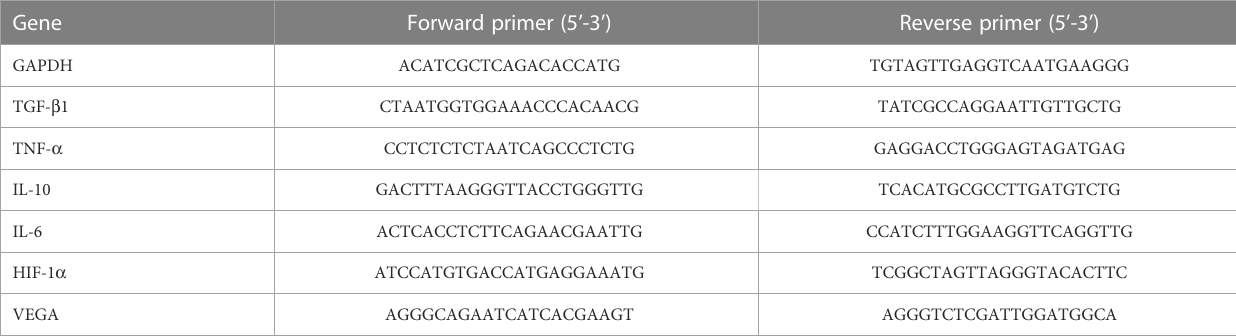
TABLE 1 The sequences of primers used for